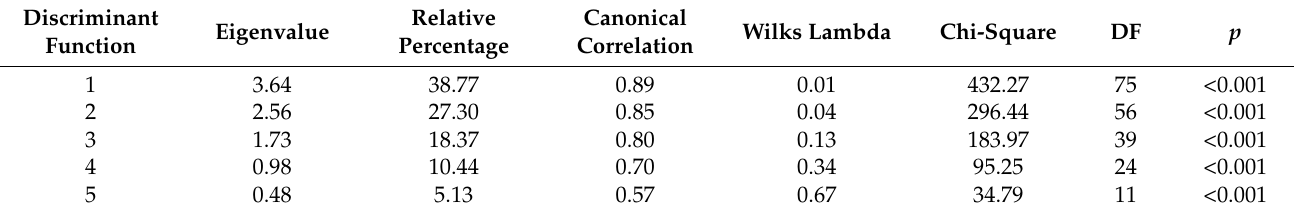
Table 5. Discriminant functions and statistics extracted of linear discriminant analysis.